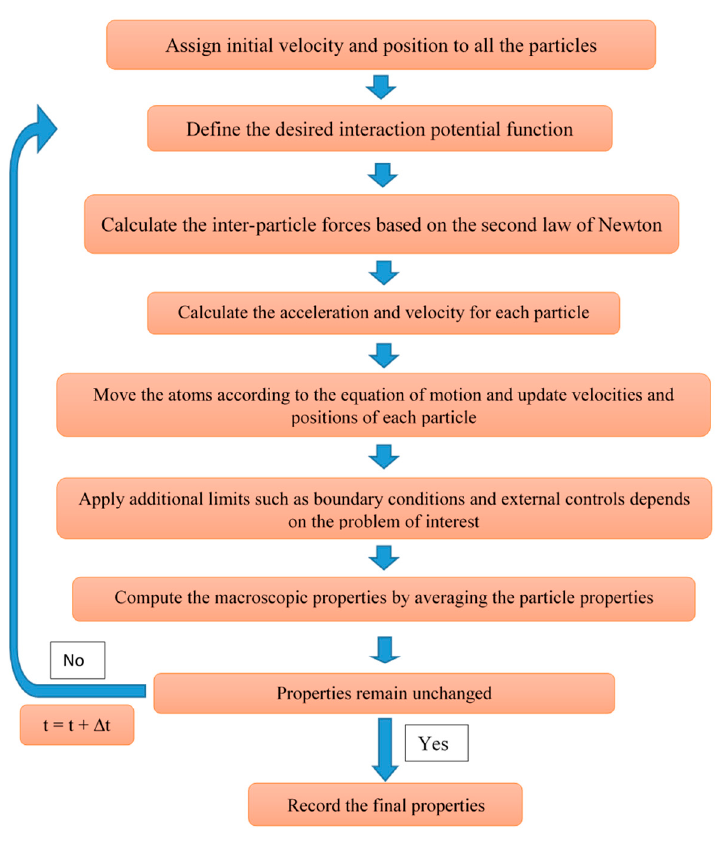
Figure 9. Simplified schematic of the MD method’s algorithm.